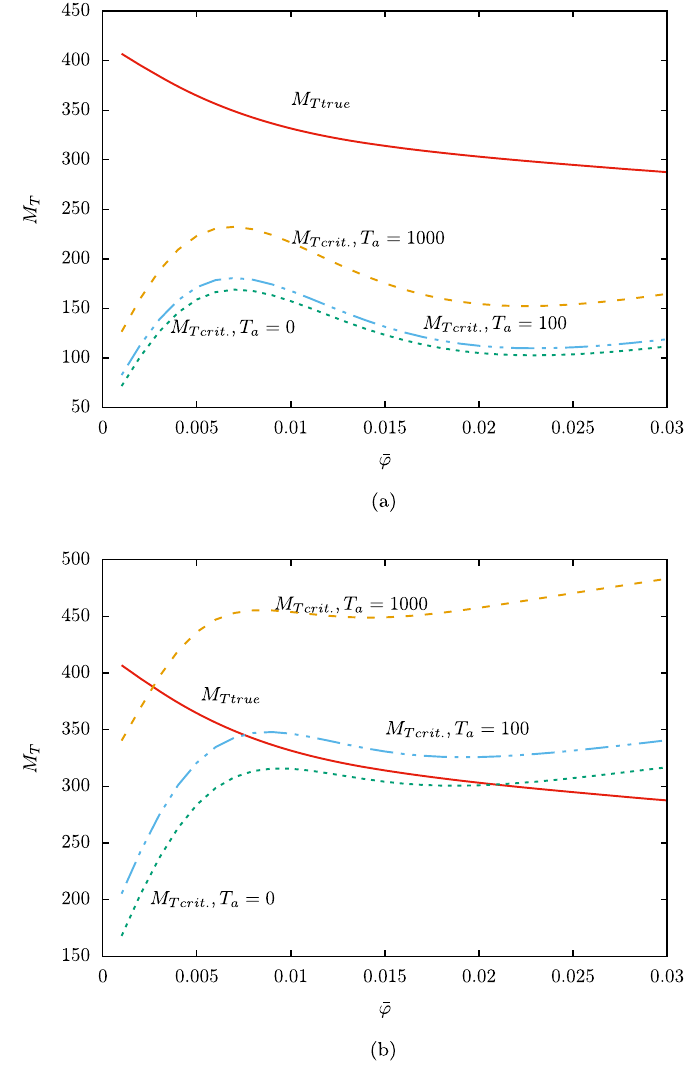
Figure 2: The true and critical temperature Marangoni numbers for DW/alumina nano fl uid with = d 30 nm p , = ∘ T Δ 2 K for average volume fractions ranging from 0.01 to 0.03. Stability boundary curves for the temperature Marangoni number are calculated based on ( a ) Model I and ( b ) Model II, using the thermal conductivity and dynamic viscosity constitutive functions proposed by Khanafer and